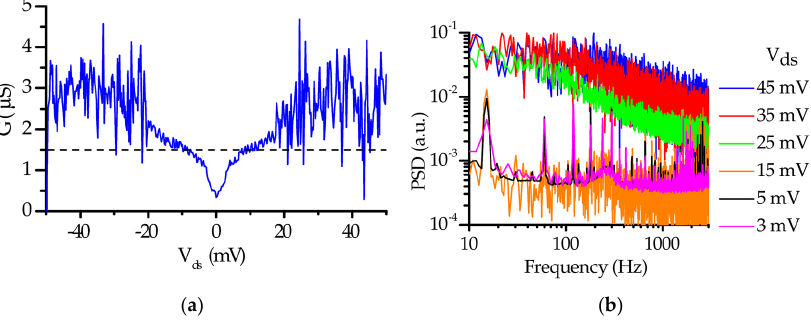
Figure 13. ( a ) G ( V ds ) dependence observed in (Ni ‐ SiO 2 ‐ Ni) SET fabricated with two RHP steps at a CBO peak. For V ds above a threshold V Th ≈ 15 mV, very strong noise is observed, but below this threshold the switching noise is much lower than in double FGA samples. The peaks of CBOs never reach G 0 /2 indicating that some NiO remains. ( b ) The spectral density of noise as a function of V ds shows two orders of magnitude increase of noise above 15 mV ( T = 0.4 K).